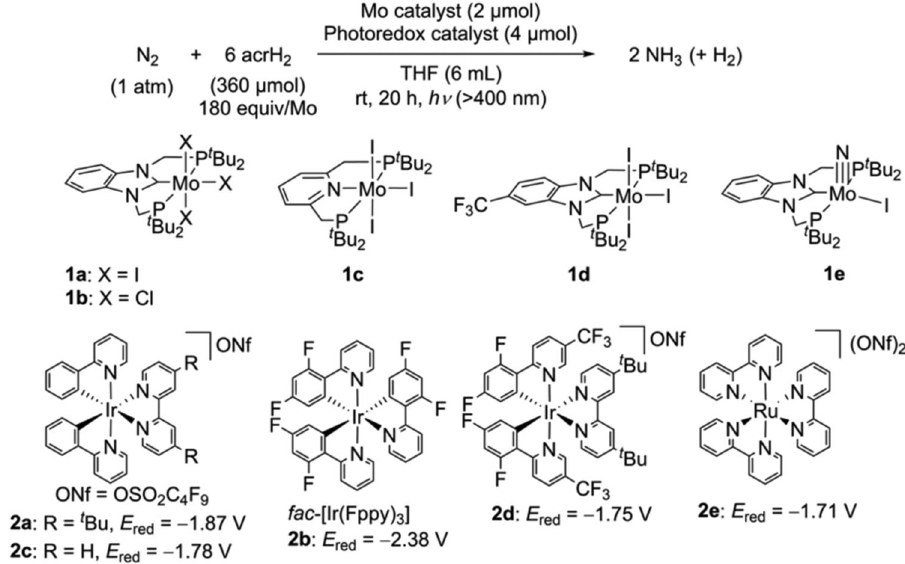
Fig. 3 | Visible Light Driven Catalytic Nitrogen Fixation Using Molybdenum Catalysts and Photoredox Catalysts. Reduction potentials of photoredox catalysts in MeCN are taken from refs. 30 – 32. E red is a potential of Ir(II/III) or